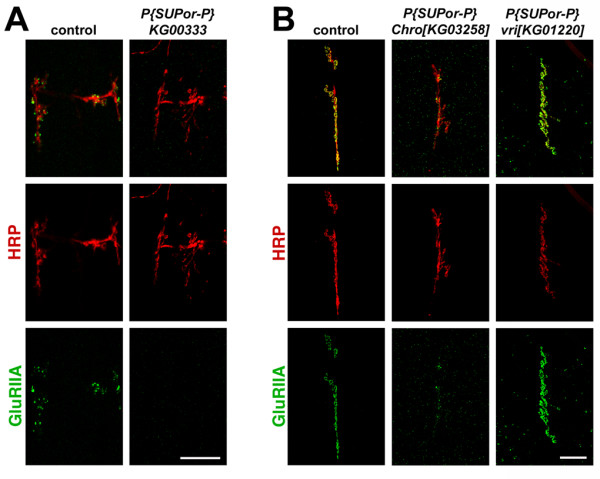
Example phenotypes identified in the screen. A: NMJs on embryonic ventral longitudinal muscles 7, 6, and 13, visualized using anti-HRP antibodies (which stain all neuronal membrane) and anti-GluRIIA antibodies (which stain postsynaptic glutamate receptors). HRP immunoreactivity is red; GluRIIA immunoreactivity is green. In wildtype NMJs (A, left column), GluRIIA immunoreactivity appears as puncta, representing clusters of postsynaptic glutamate receptors. In homozygous P{SUPor-P}KG00333 mutants (A, right column), GluRIIA immunoreactivity is eliminated. B: NMJs on third instar larval longitudinal muscles 7 and 6, visualized using anti-HRP and anti-GluRIIA antibodies. In wildtype NMJs (B. left column), GluRIIA immunoreactivity appears as large blobs, representing developmentally merged puncta, at sites of innervation. In homozygous P{SUPor-P}Chro [KG03258] mutants (B, middle column), synaptic GluRIIA immunoreactivity is dramatically decreased, although extrasynaptic receptors remain prominent. In contrast, synaptic GluRIIA immunoreactivity is dramatically increased in homozygous P{SUPor-P}vri [KG01220] mutants (B, right column). Scale bars: 10 micrometers.